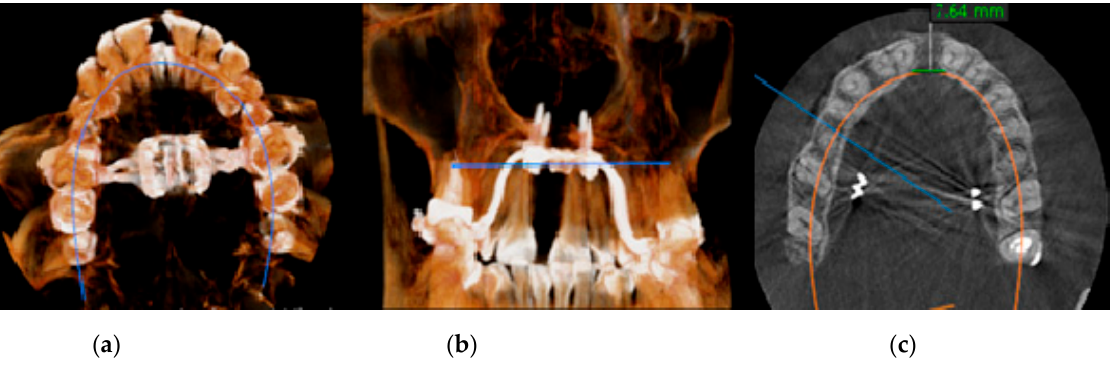
Figure 6. Interincisal diastema formation. ( a )Axial view ( b ) Frontal view ( c ) Cross-sectional view.